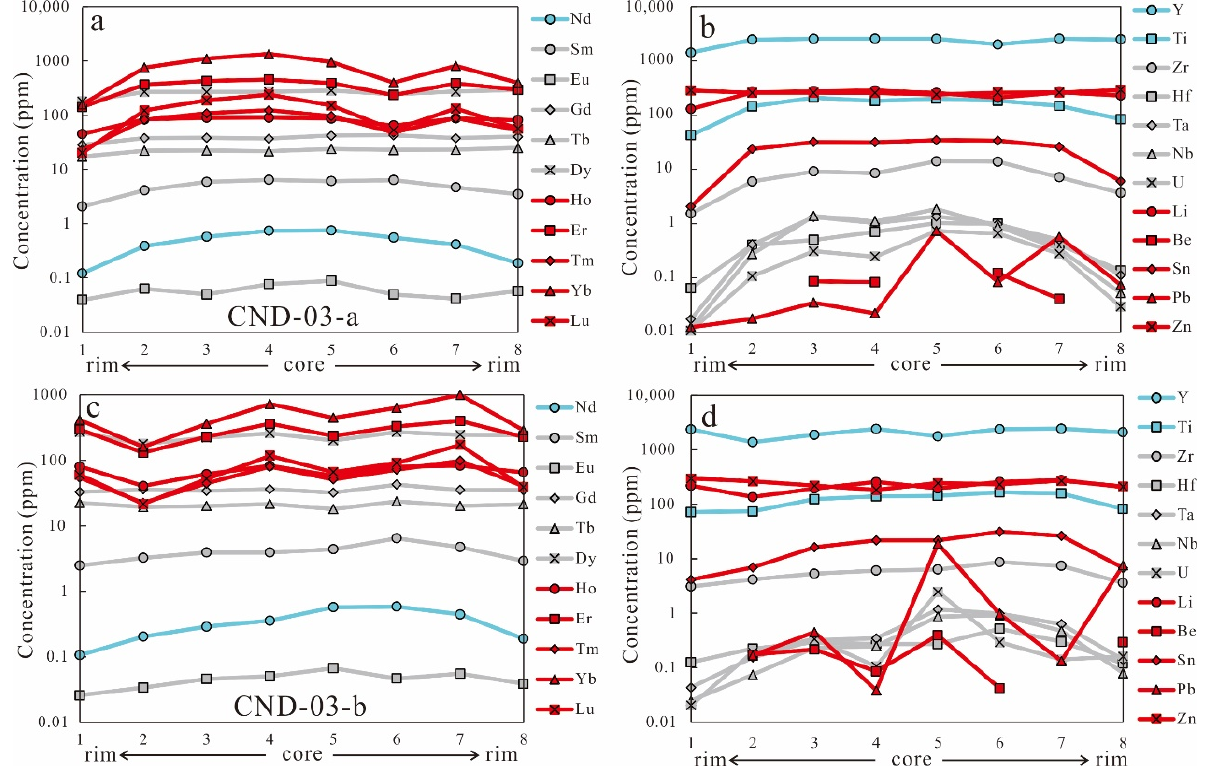
Figure 6. ( a – d ) Rare earth element and trace element core – rim profiles of garnet from the muscovite granite.